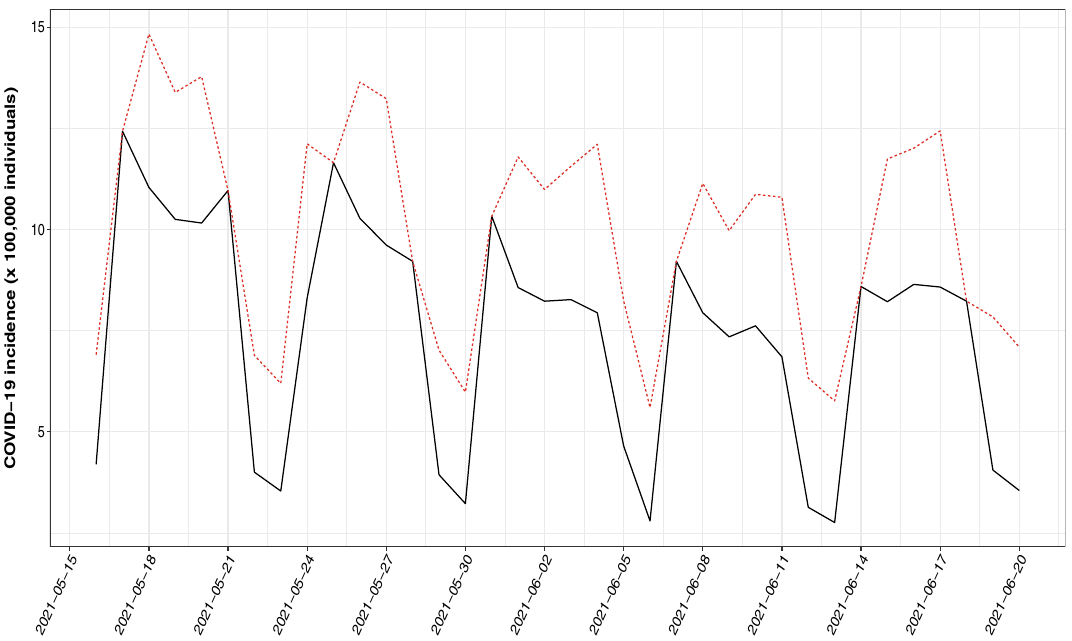
Figure 5. Registered (black solid line) and estimated (red dotted line) COVID-19 incidence in Catalonia in the period